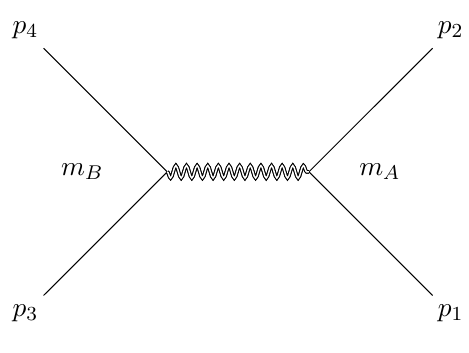
Figure 2 . Tree Level